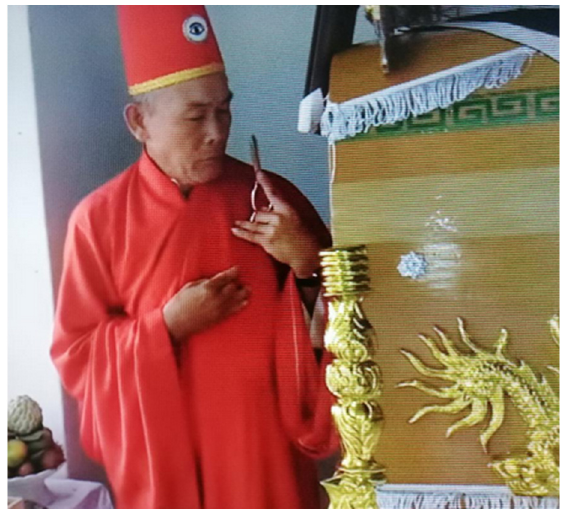
Figure 10. Talismanic writing for H à nh ph é p Ðo ạ n c ă n , and the seal of the Protector of Dharma, performed